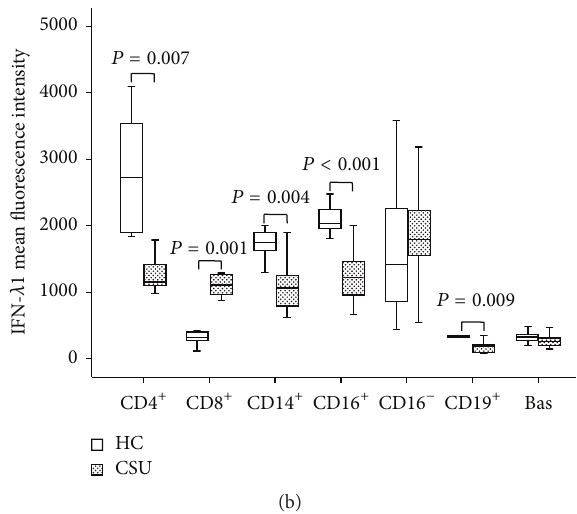
Figure 2: Flow cytometry analysis of the expression of interferon- (IFN-) 𝜆 1 in peripheral blood leukocytes. (a) showed a representative graph of the changes in the mean fluorescence intensity (MFI) of IFN- 𝜆 1 in CD4 + (helper T cells), CD8 + (cytotoxic T cells), CD14 + (monocytes), CD16 + (neutrophils), CD19 + cells (B cells), CD123 + HLA-DR − (basophils), and CD16 − (eosinophils) in healthy control subjects (HC) and patients with urticaria, respectively. Gate represents gating strategy. (b) represents a boxplot of the expression of IFN- 𝜆 1 in peripheral blood leukocytes of the patients with urticaria and HC, which indicates the median (horizontal line), interquartile range, the largest, and smallest values other than outliers (whiskers) and the outliers (O). Each piece of data represented a group of minimum 7 subjects. 𝑃 < 0.05 was taken as statistically significant.